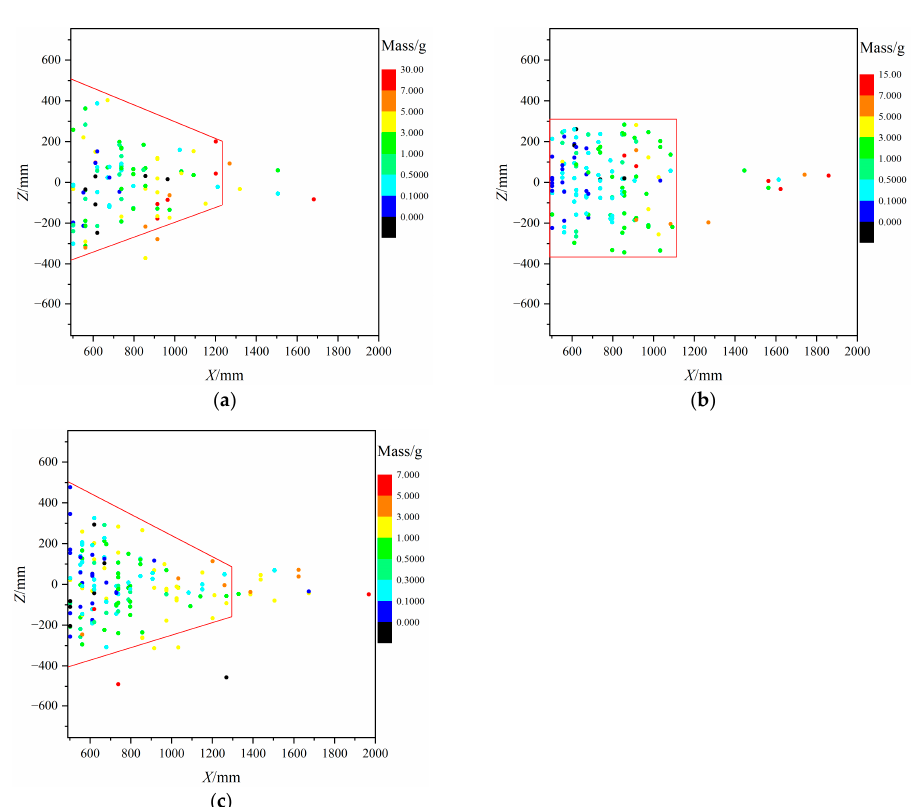
Figure 8. Two-dimensional projection of the striking area on the XZ plane. ( a ) L / D = 1.66 ( b ) L / D = 2.4 ( c ) L / D = 3.86.